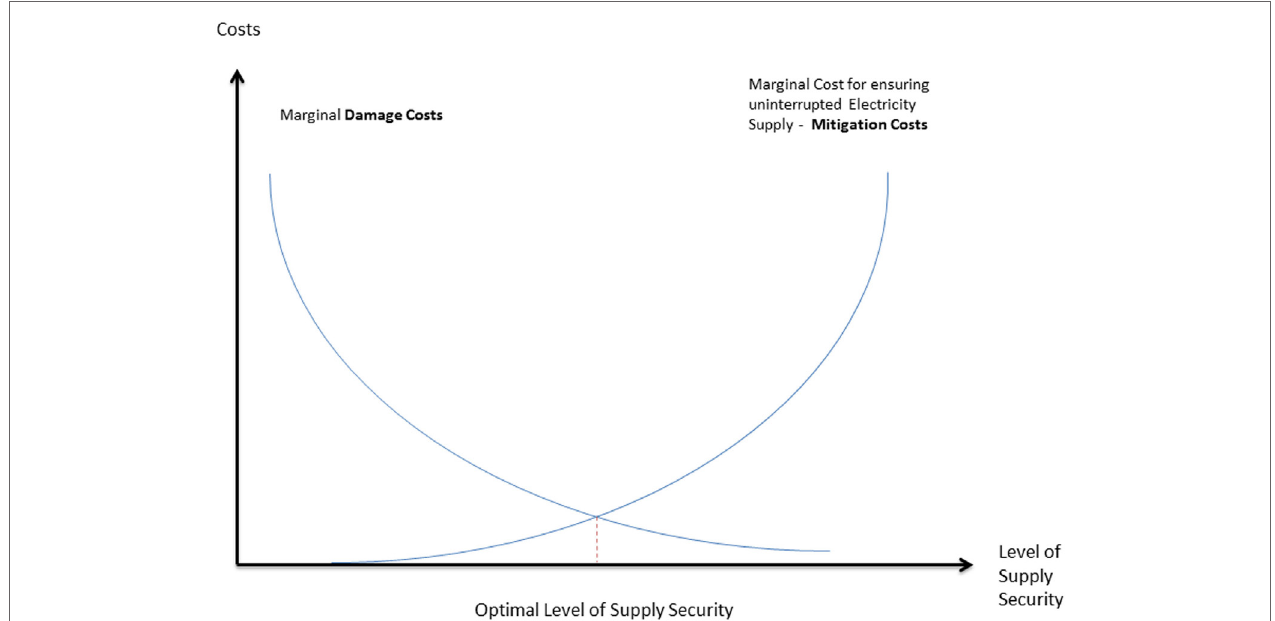
FiGURe 1 | Optimum power supply security . Source Bliem